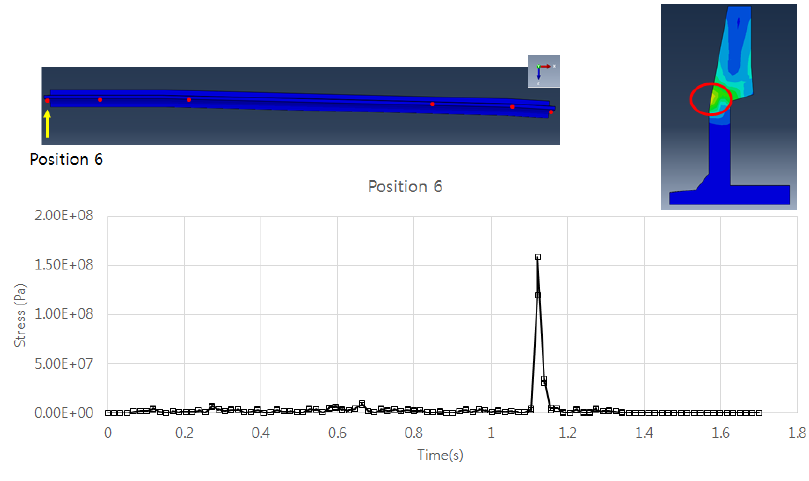
Figure 7. Histories of maximum von Mises stress at 10 km/h bogie’s speed.